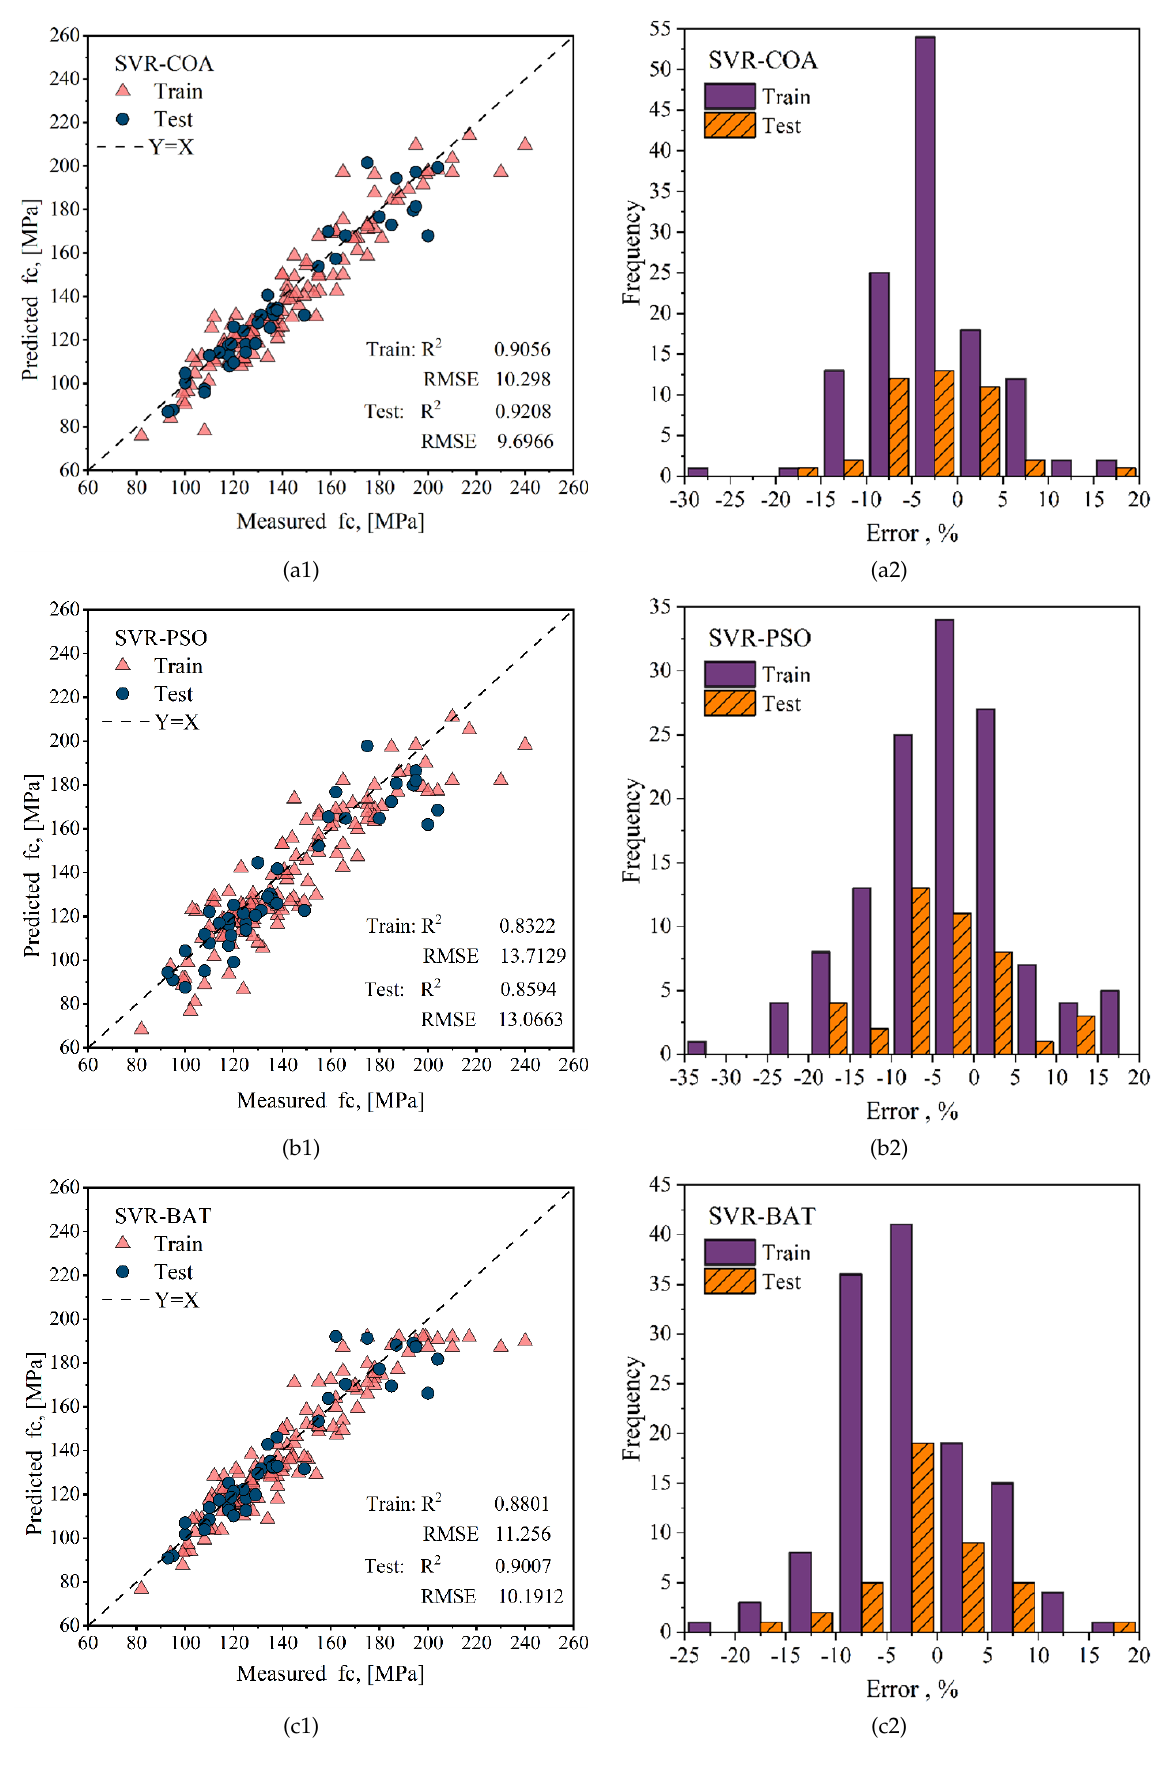
Fig. 4. Results of the hybrid SVR models in estimating the f c of UGWC